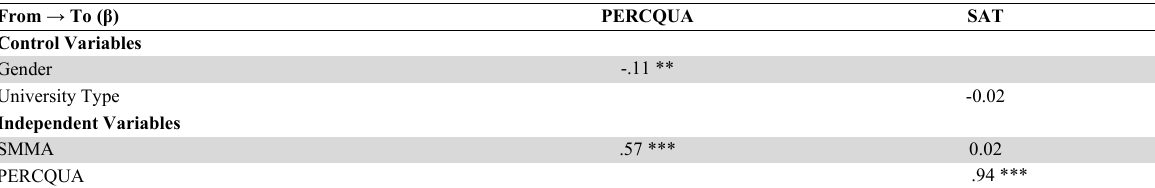
Results of SEM model